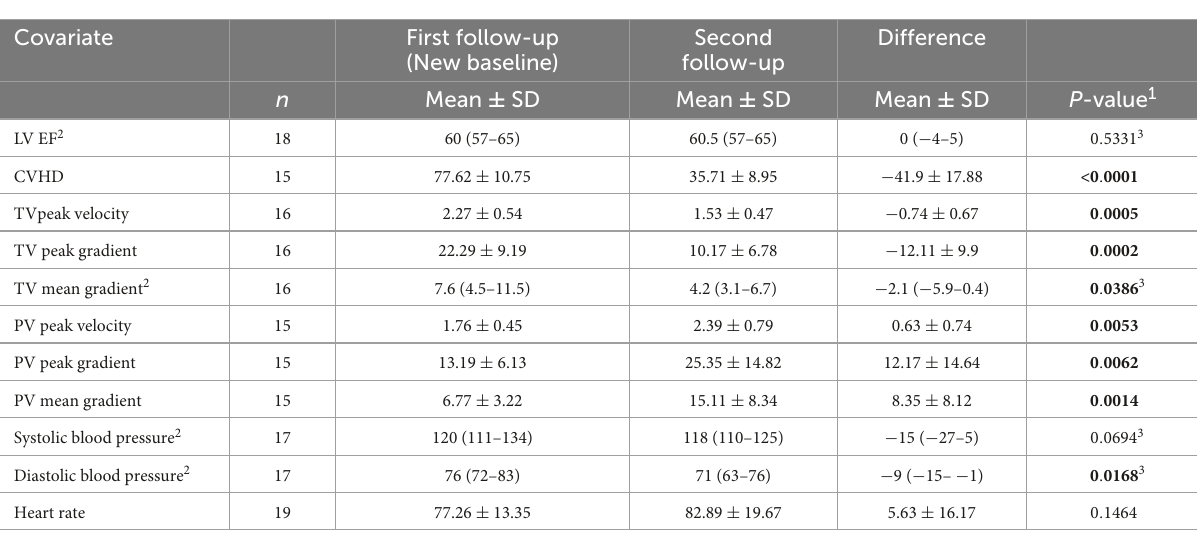
Second (New baseline)